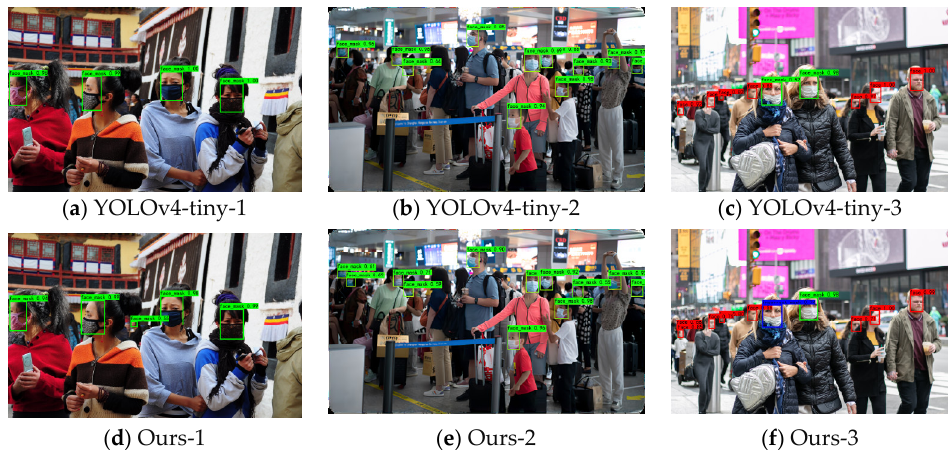
Figure 9. Comparison of YOLOv4-tiny and our algorithm for partial-scene mask detection.